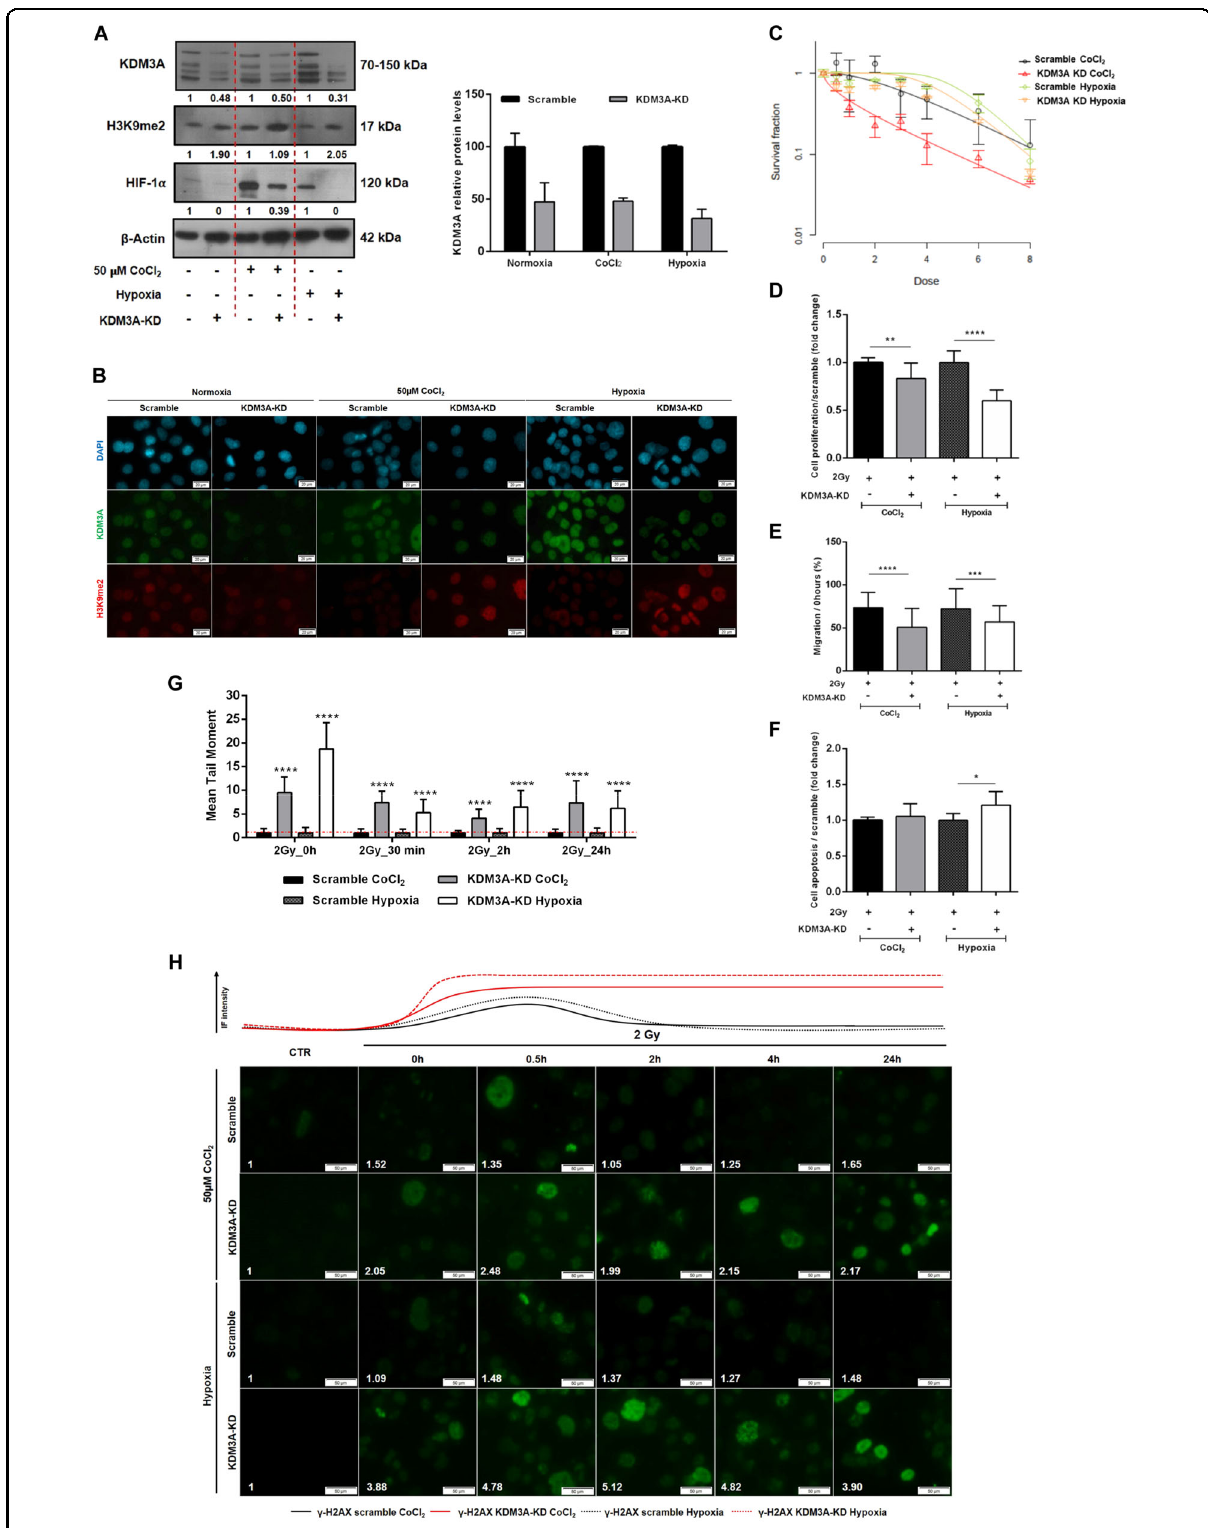
Fig. 4 (See legend on next